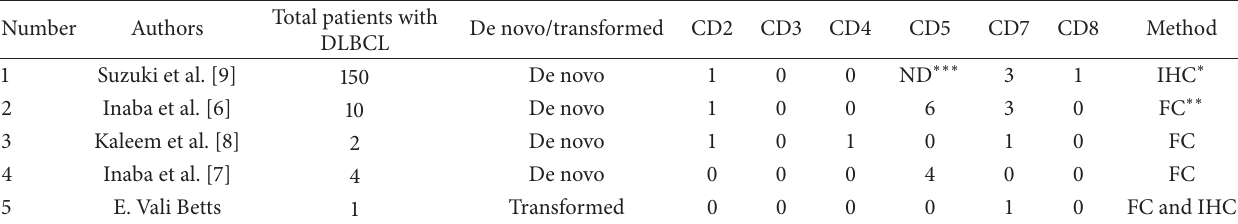
Figure 2: Neoplastic cells express CD19 with a subset with expression of CD7. These cells have a high forward scatter, consistent with the CD7 positive large cells. Table 1: Immunohistochemical expression of non-CD5 T-cell antigens in DLBCLs. The manuscripts noted in the table do not discriminate the various non-CD5 positive DLBCLs in germinal center versus nongerminal center phenotype. According to Suzuki et al., the rate of non- CD5 T-cell antigen expression in DLBCLs is extremely low with only ∼ 0.3% of their known cases. Inaba et al. evaluated 10 cases of DLBCL of which 3 of them showed expression of CDC7 [6]. In another study Inaba et al. showed no cases of DLBCL with expression of CD7 by evaluation of 4 cases